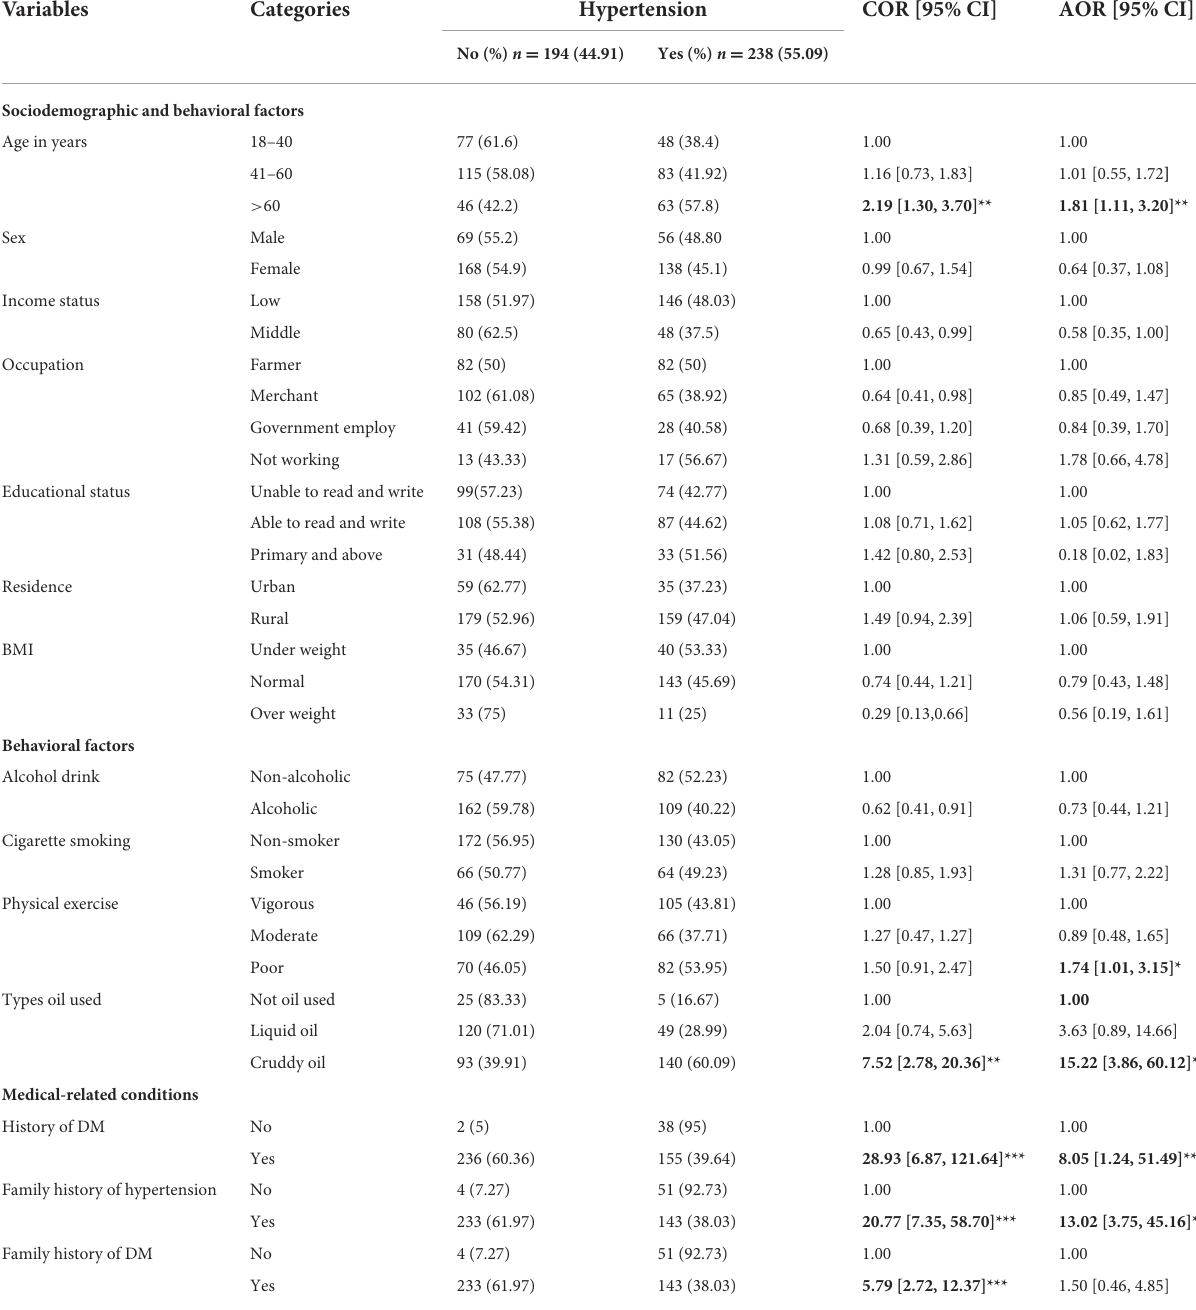
TABLE 3 Bivariable and multivariable analyses of factors associated with hypertension among patients in the Kiraker and Nigus Ketema primary hospitals, Northwest Ethiopia, 2021. Variables